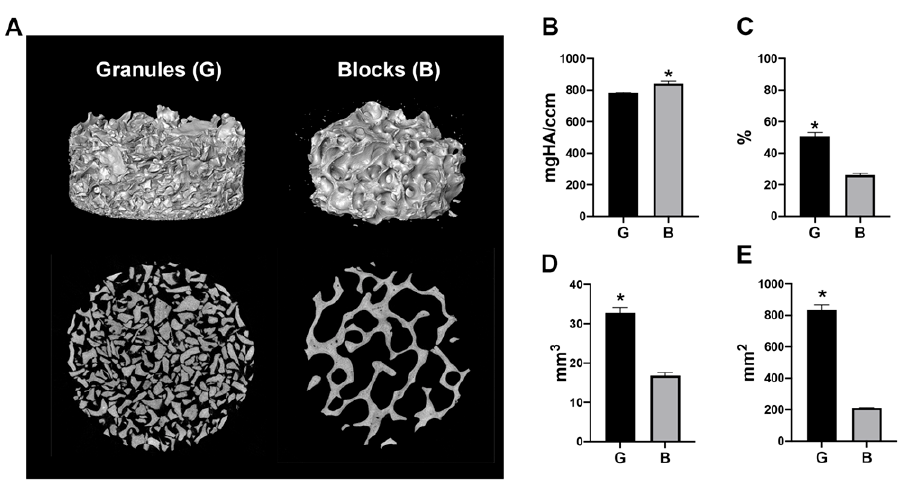
Figure 1. The material volume and surface area of deproteinized bovine bone mineral (DBBM) granules and blocks filled in a 6.4 mm diameter × 2 mm height cylinder. ( A ) Three-dimensional (3D)